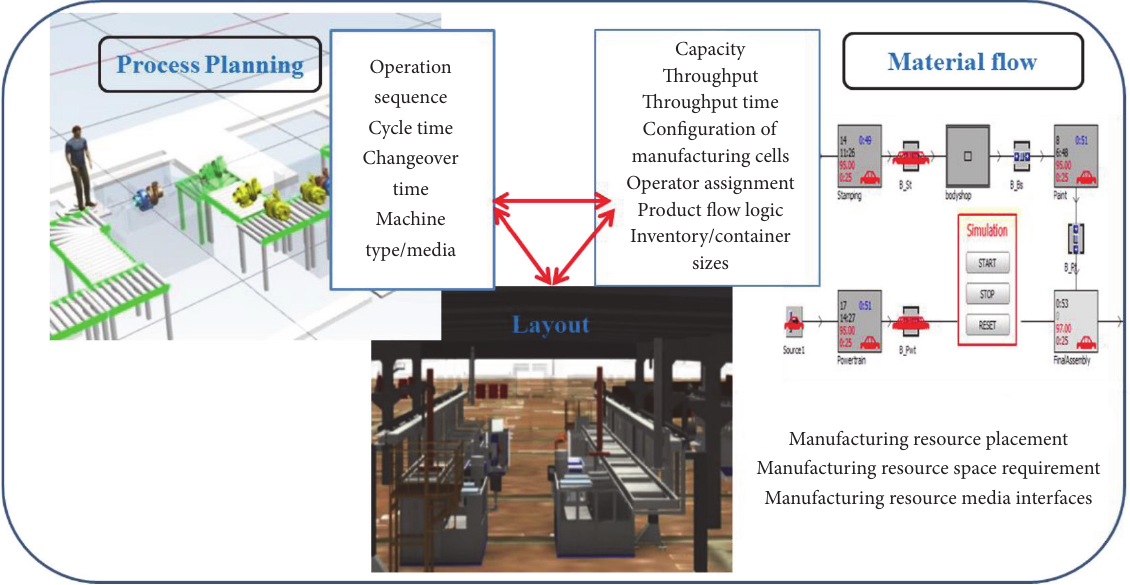
Figure 13: Interrelationship among three domains (layout design, discrete event simulation, and process planning).